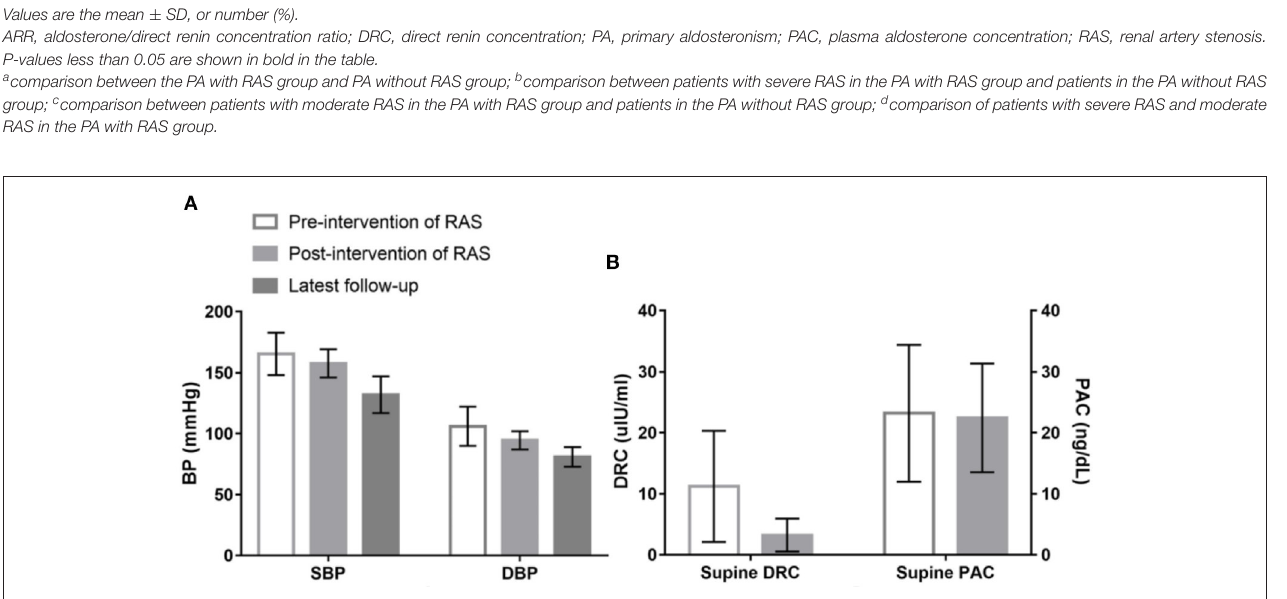
± 21 mmHg; P < 0.001), DBP (79 ± 7 vs. 104 ± 16 mmHg;